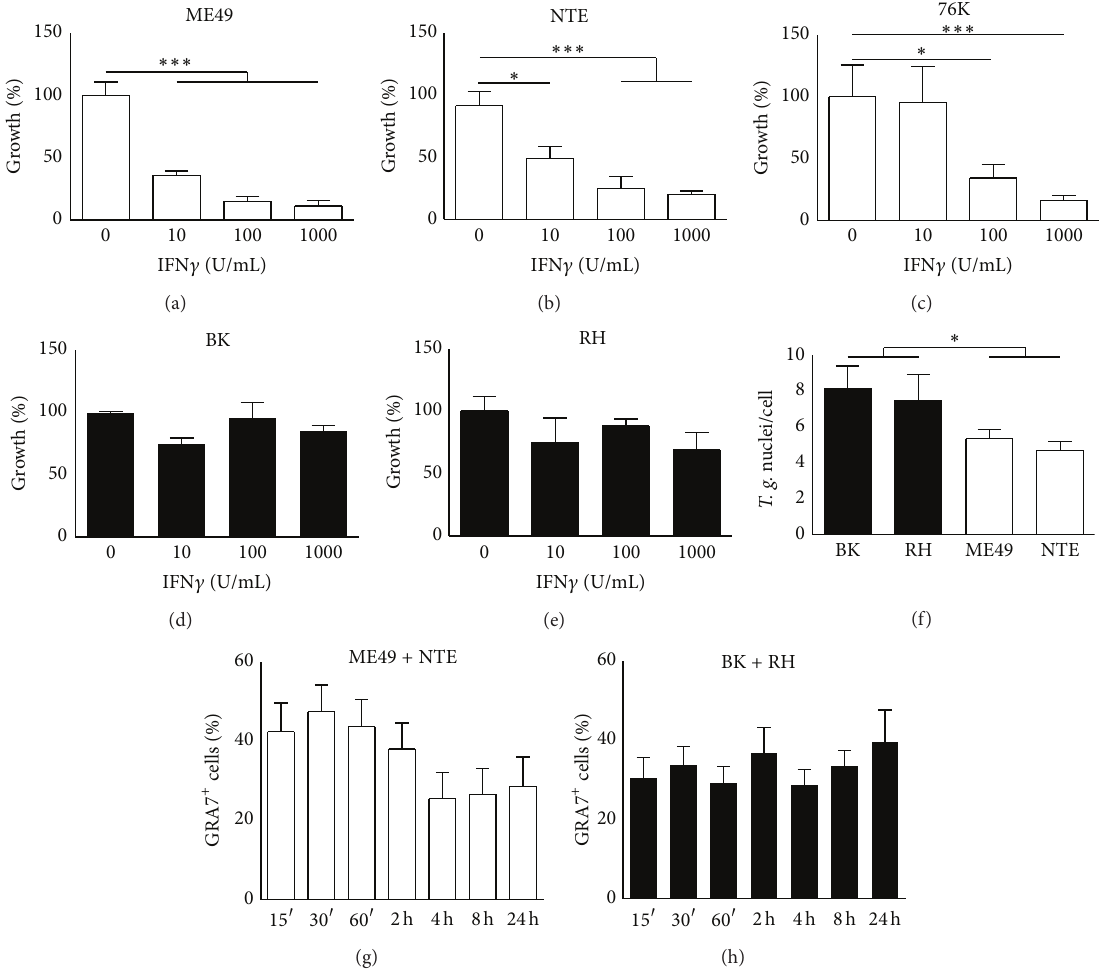
Figure 1: Growth of different T. gondii strains in IFN 𝛾 -stimulated astrocytes. ((a)–(e)) Astrocytes were prestimulated with the indicated IFN 𝛾 concentrations and infected for 72 h with different T. gondii strains (MOI: 1). T. gondii growth was measured by incorporation of 3 H-uracile for the last 24 h of culture using the fact that T. gondii is able to incorporate uracile selectively, while in host cells the necessary enzyme is lacking [28]. Uracile incorporation after infection with the different T. gondii strains in unstimulated astrocytes was set to 100%, and incorporation in stimulated astrocytes was calculated accordingly. Depicted is mean ± standard error of mean (SEM) of four independent experiments with triplicates ( ∗ 𝑃 < 0.05 ; ∗∗∗ 𝑃 < 0.001 ). Avirulent T. gondii strains (white; (a)–(c)) were tested as well as virulent strains (black; (d), (e)). (f) Astrocytes were prestimulated with 100U/mL IFN 𝛾 and pulse-infected with the indicated T. gondii strains (MOI: 10). After an incubation time of 48 h, infected cells were fixed and tachyzoites per PV were counted by identification of DAPI-labelled T. gondii nuclei (mean ± SEM, ∗ 𝑃 < 0.05 ). ((g)-(h)) Astrocytes were prestimulated with 100U/mL IFN 𝛾 and infected with T. gondii (MOI: 10), and after the indicated time points the vacuoles per 100 cells were identified via GRA7 staining. Depicted is mean ± SEM for three independent infection experiments for every strain in duplicates with the averaged results over the avirulent strains (ME49 and NTE, white) and virulent strains (BK and RH,